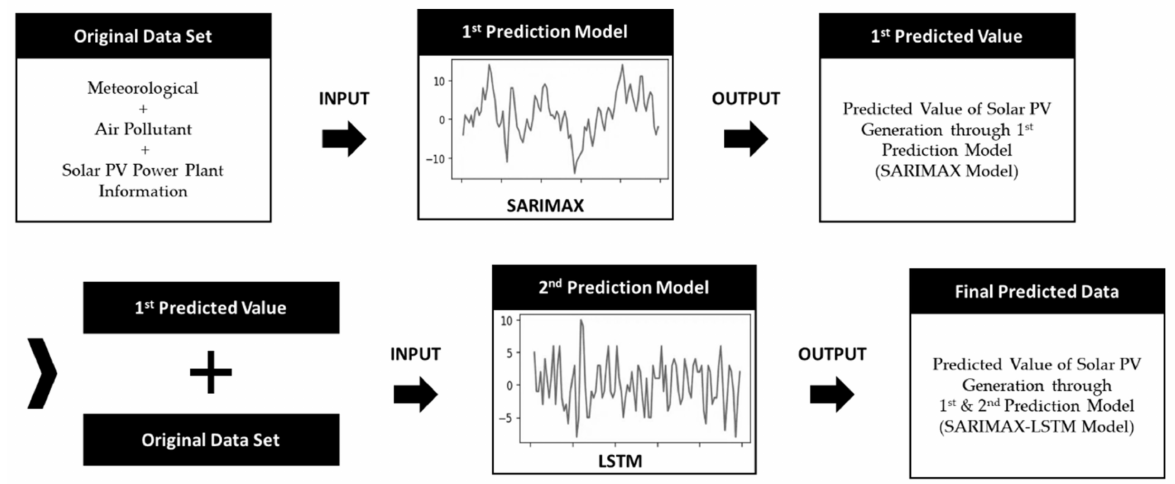
Figure 7. The architecture of the SARIMAX-LSTM model. Using the criteria of the American Society of Heating, Refrigerating, and Air-Conditio- ning Engineers (ASHRAE) Guideline 14 applied by energy managers to improve energy efficiency, we will additionally verify the performance of the solar PV generation prediction model [49]. For the objective evaluation of the solar PV generation prediction model, the mean bias error ( MBE ) and the coefficient of variation ( Cv ) criteria in the ASHRAE Guide- line 14 were applied and are expressed as equations 4 and 5. For MBE , the performance increases as it converges to 0, regardless of the ± sign. However, in this study, absolute values have been taken for the results, thereby increasing intuition and convenience of comparison. From Table 9, according to the criteria of ASHRAE Guideline 14, the hourly prediction is defined within MBE ± 10% and Cv 30%.